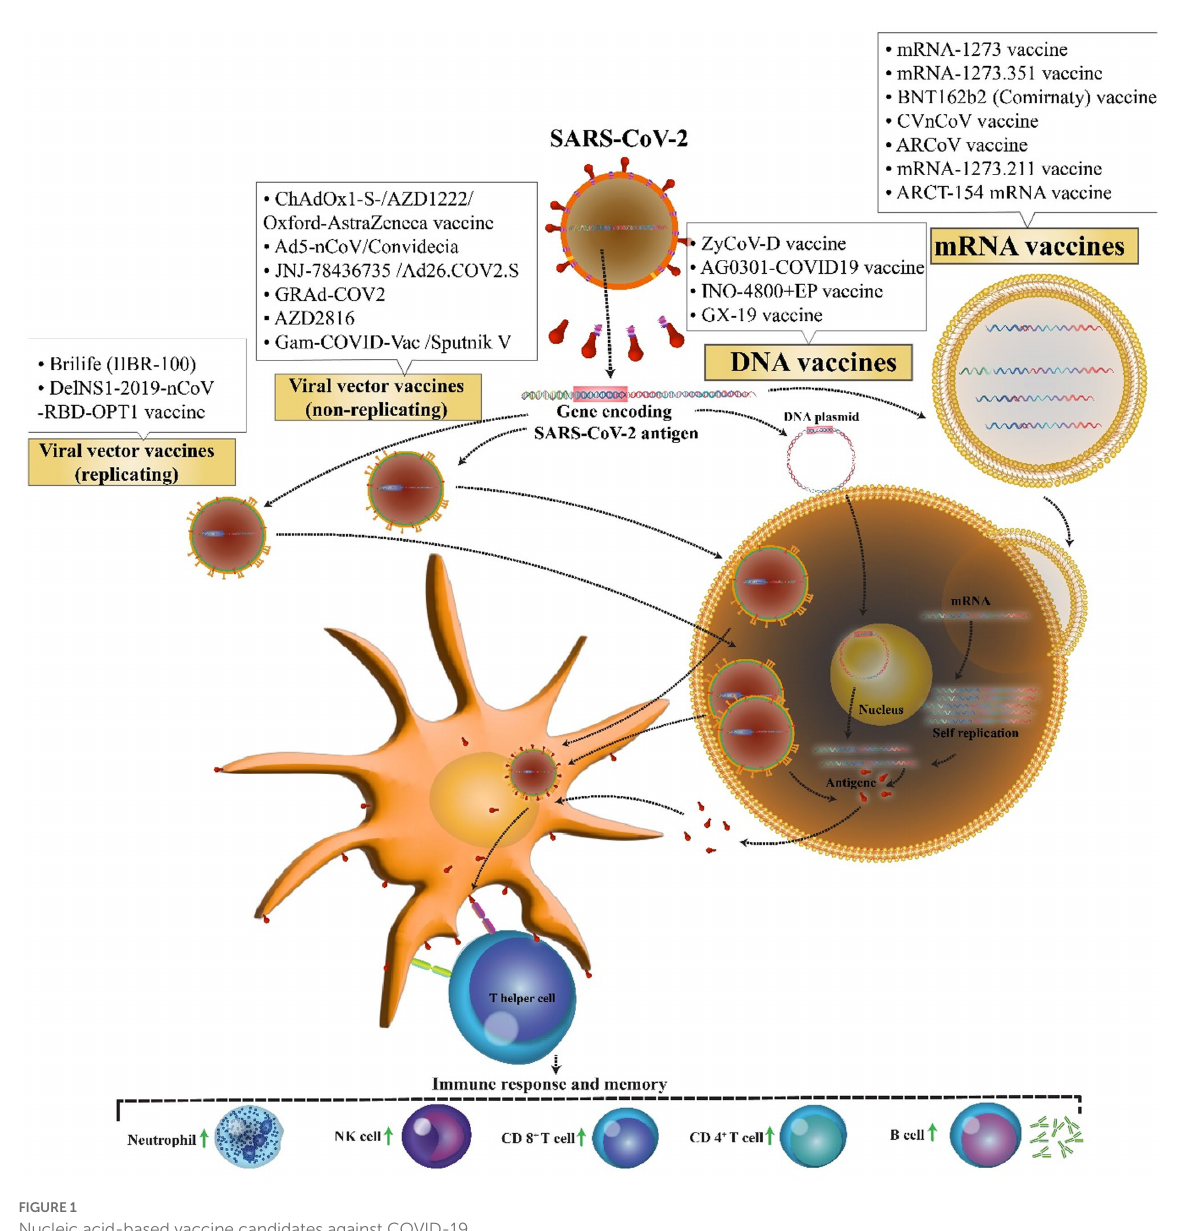
FIGURE 1 Nucleic acid-based vaccine candidates against